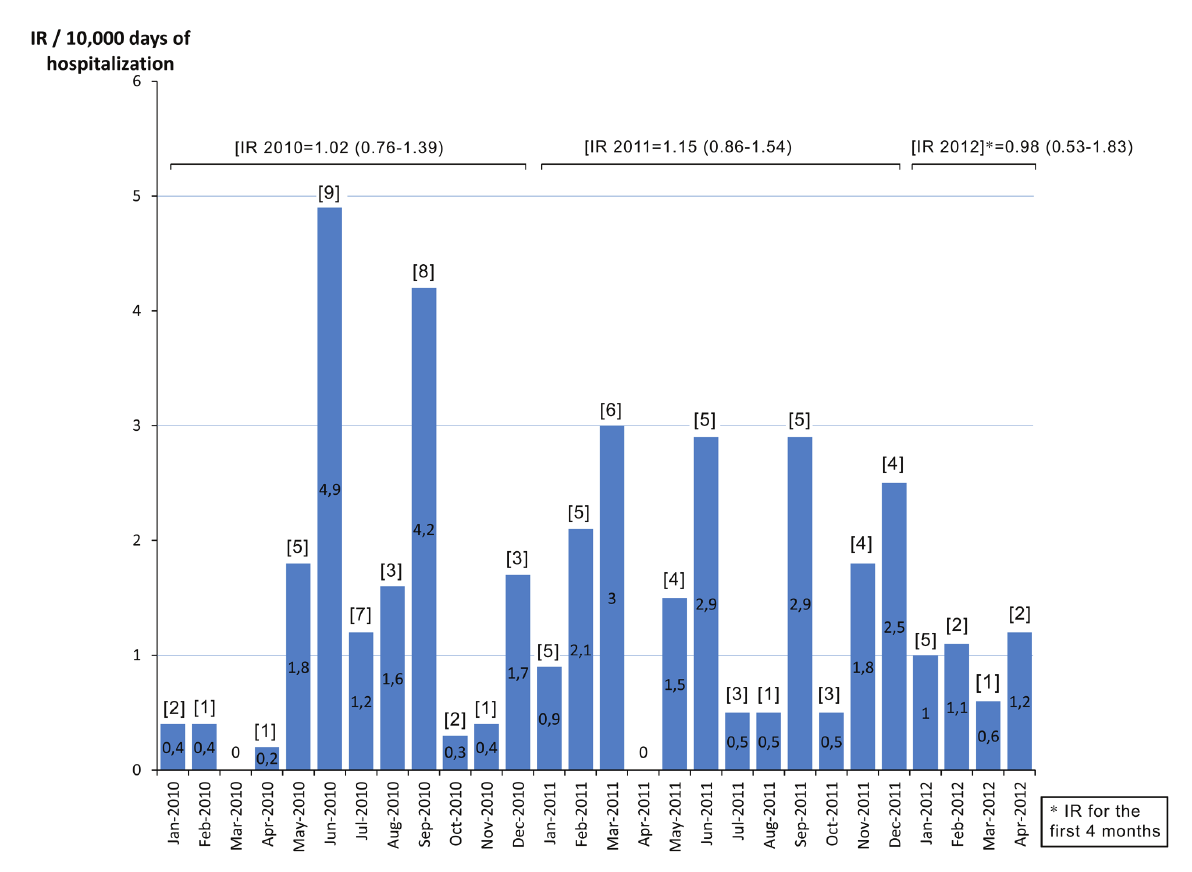
Figure 1. Incidence rate of KPC- Kp infections/10 , 000 days of hospitalization (IR). Number of cases is shown in brackets